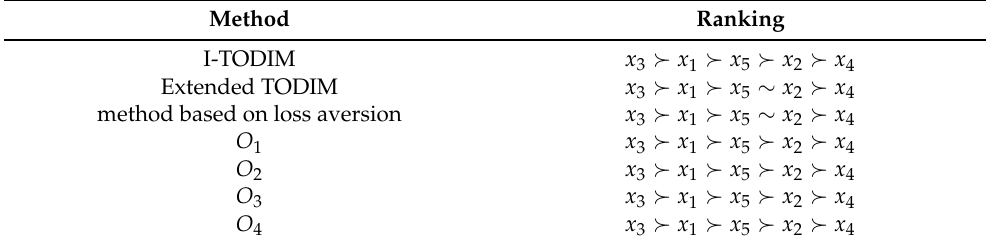
Table 4. Summary of the rankings obtained from the proposed method and the other